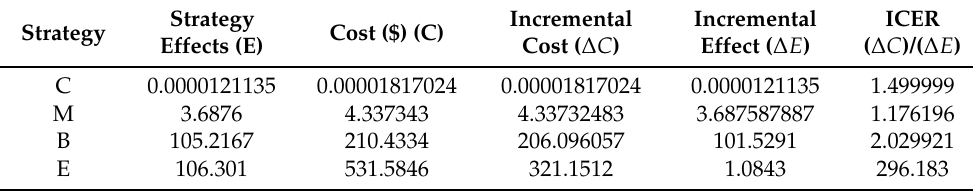
Table 9. Exclusion of dominated alternative intervention strategies for Endemic